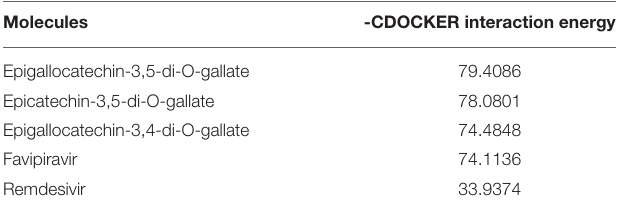
TABLE 1 | Selected tea bioactive molecules and FDA-approved drugs based on -CDOCKER interaction energy. Molecules -CDOCKER interaction energy